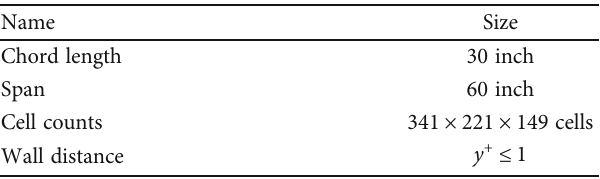
Figure 5: Mesh domain of the elliptical airfoil. Table 2: 3D model and mesh